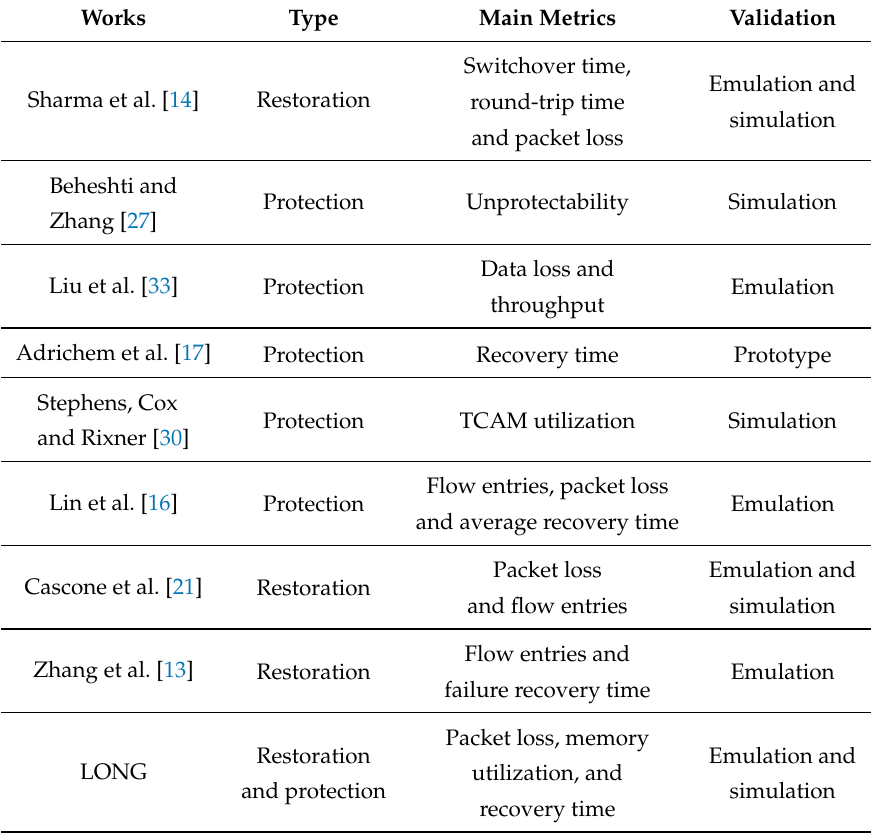
Table 1. A comparison of related works with regards to type (restoration or protection), main metric (depends on each work) and validation methodology (simulation, emulation or prototype). TCAM, Ternary Content Addressable Memory; LONG, Local Node Group fast